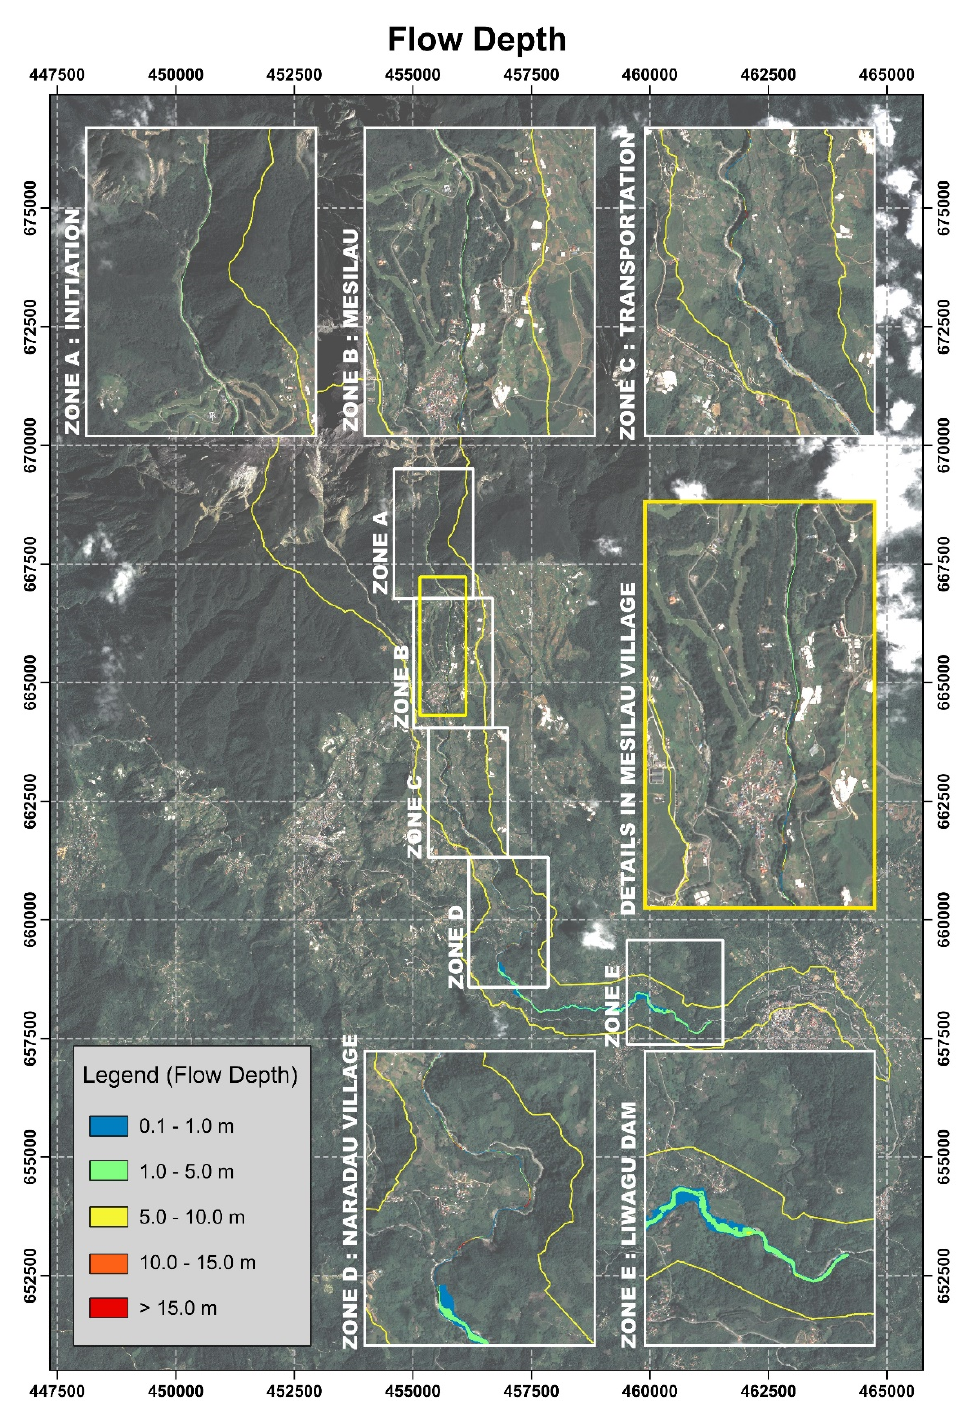
Figure 13. The flow depth simulation results within the Mesilau watershed.